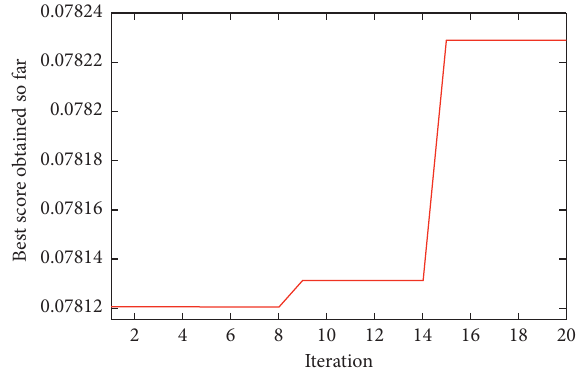
Figure 4: IPSO convergence curve for VMD parameter optimization.